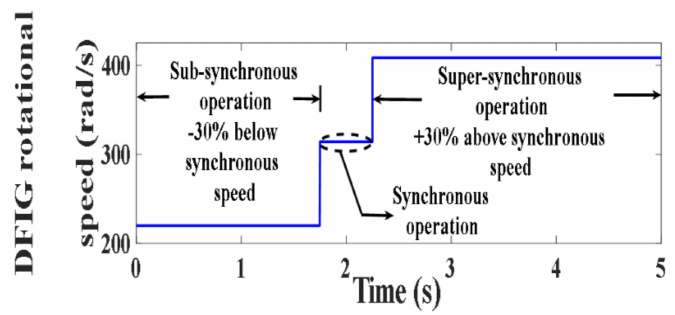
Figure 9. Prime mover operating speeds